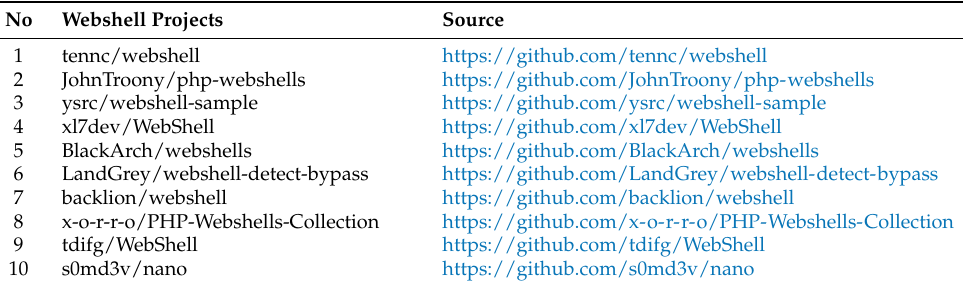
Table 3. The sources of the webshells (Accessed on 7 January